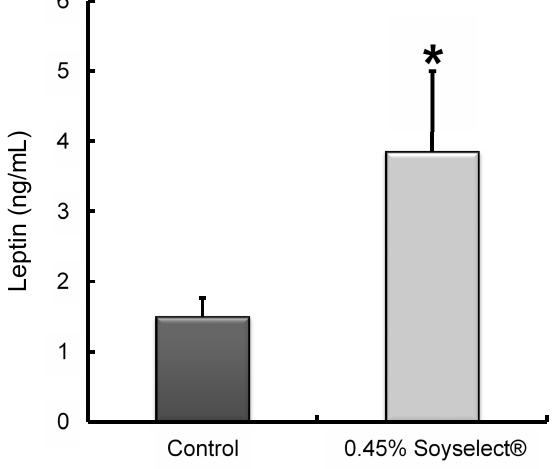
Figure 1. Leptin circulating concentrations in mice receiving either chow diet (control) or 0.45% Soyselect ® during eight weeks ( n = 7 per group). * p < 0.05 as compared with